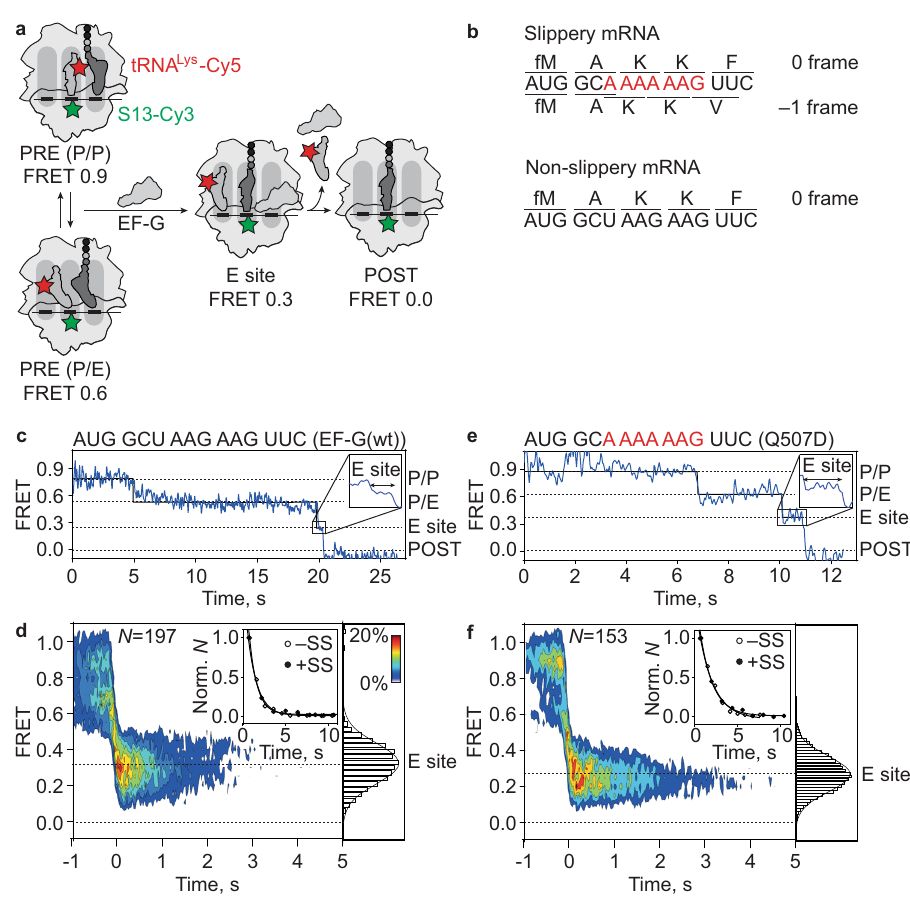
Fig. 4 Translocation trajectory of deacylated tRNA. a Schematic of smFRET experiment monitoring movement of tRNA Lys -Cy5 (Cy5; red star) relative to protein S13-Cy3 (green star). Translocation is induced by addition of EF-G to immobilized PRE complexes. FRET values corresponding to P, P/E and E states were determined in independent experiments (Supplementary Fig. 5 and 6). b Coding sequences of mRNA constructs. Slippery sequence encodes fMet- Ala-Lys-Lys-Phe in 0 frame and fMet-Ala-Lys-Lys-Val in − 1 frame. Non-slippery mRNA encodes only 0-frame fMet-Ala-Lys-Lys-Phe peptide because tRNA Lys does not base pair with the – 1-frame GAA. c Representative smFRET time trace of tRNA translocation on non-slippery mRNA in the presence of EF-G(wt) showing step-wise transition from FRET 0.9 (P/P) to 0.6 (P/E) to 0.3 (E site) to 0.0 (dissociation). d Contour plot showing distribution of FRET ef fi ciencies during translocation on non-slippery mRNA by EF-G(wt). Transitions occur either from FRET 0.9 (P site) or 0.6 (P/E) to FRET 0.3 (E site). Traces are synchronized to the fi rst transition below FRET 0.5. Histogram at the right shows distribution of FRET values after synchronization. Inset shows rates and curve fi ts of tRNA dissociation from E site on slippery (closed circles) and non-slippery (open circles) mRNA (Supplementary Fig. 6b and Table 2). Normalization was performed by division by the number of transitions ( n ). Data are from four independent experiments ( N = 4). e Representative smFRET time trace of tRNA translocation on slippery mRNA in the presence of EF-G(Q507D) showing step-wise transition from FRET 0.9 (P site) to 0.6 (P/E) to 0.3 (E site) to 0.0 (dissociation), similar to EF-G(wt) ( c ). f Contour plot showing the distribution of FRET ef fi ciencies during translocation on slippery mRNA by EF-G(Q507D). Transitions occur either from FRET 0.9 (P site) or 0.6 (P/E) to FRET 0.3 (E site). Inset shows rates and curve fi ts of tRNA dissociation from E site on slippery (closed circles) and non-slippery (open circles) mRNA. Normalization was performed by division by the number of transitions ( n ) (Supplementary Fig. 6c and Table 2). Data are from three independent experiments ( N = Supplementary Fig. 9c, d, Table 2). In all cases, translocation of deacylated tRNA is fast, directional, and irreversible. Notably, on ribosomes where pept-tRNA translocates slowly, translocation and subsequent dissociation of deacylated tRNA is much faster than the movement of pept-tRNA (Tables 1 and 2), i.e., trans- location of pept-tRNA from the A to the P site is not yet com- pleted when deacylated tRNA has already cleared the E site. This indicates that movements of pept-tRNA are uncoupled from the displacement of deacylated tRNA on the fraction of ribosomes that undergo frameshifting, allowing pept-tRNA to more easily access the – 1-frame codon after the E-site tRNA release.